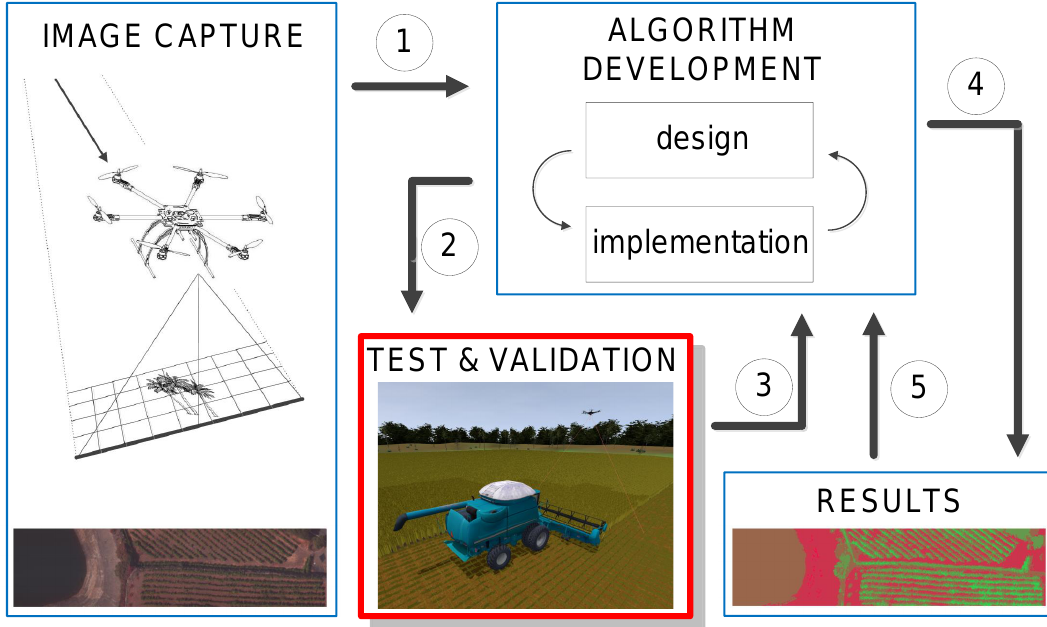
Figure 1. Proposed validation and verification